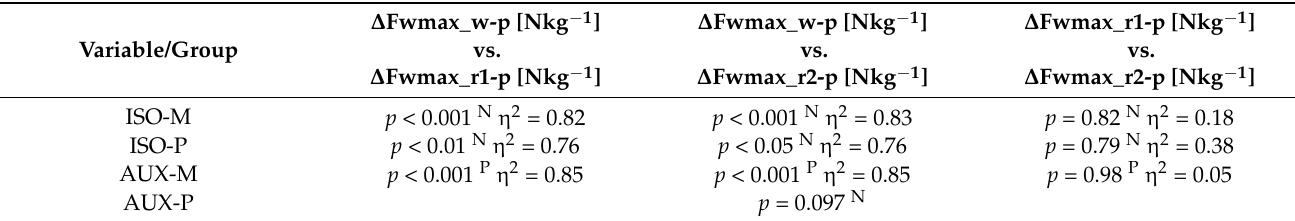
Table 3. Results of the ANOVA analysis of variance for repeated measures and the post-hoc test for changes in maximal relative strength compared to baseline in individual periods of the experiment in groups of participants.